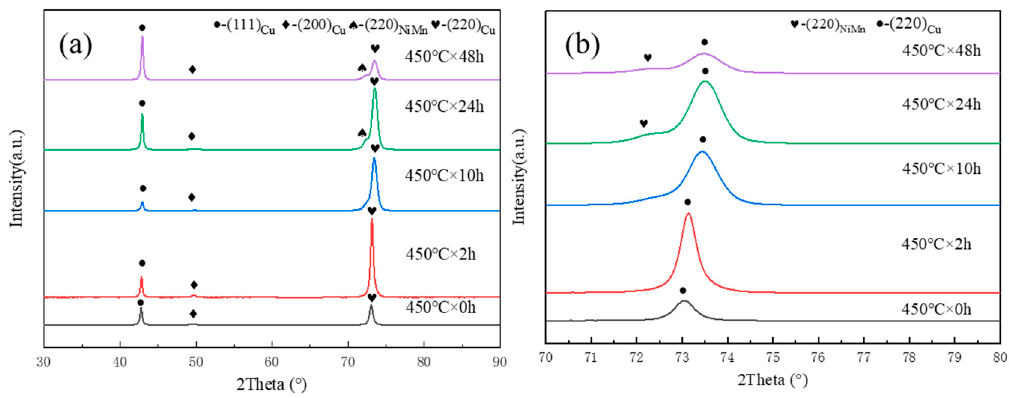
Figure 5. The XRD patterns of the rolled specimens aged at 450 °C for different time in different 2 θ ranges, ( a ) 30–90°, ( b ) 70–80°.